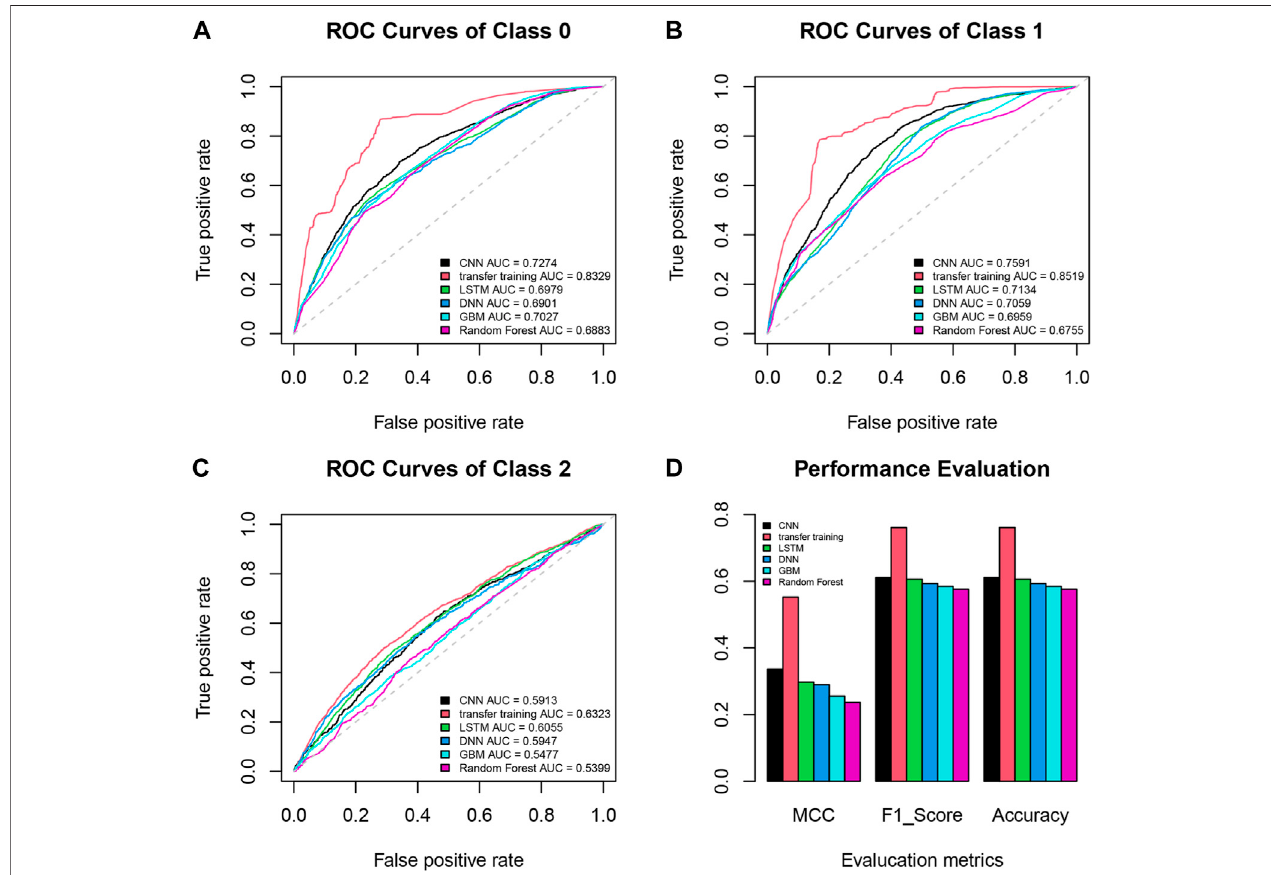
FIGURE8| Receiver operating characteristic(ROC) curves displayingtheperformancecomparison ofSeqNetQuake-TL, gradient boosting machine (GBM), deep neural network (DNN), random forest (RF), convolutional neural network (CNN), and long short-term memory (LSTM) models for (A) class 0, (B) class 1 and (C) class 2. (D) Bar plot curves of Matthews correlation coef fi cient (MCC), F1 score, and accuracy.